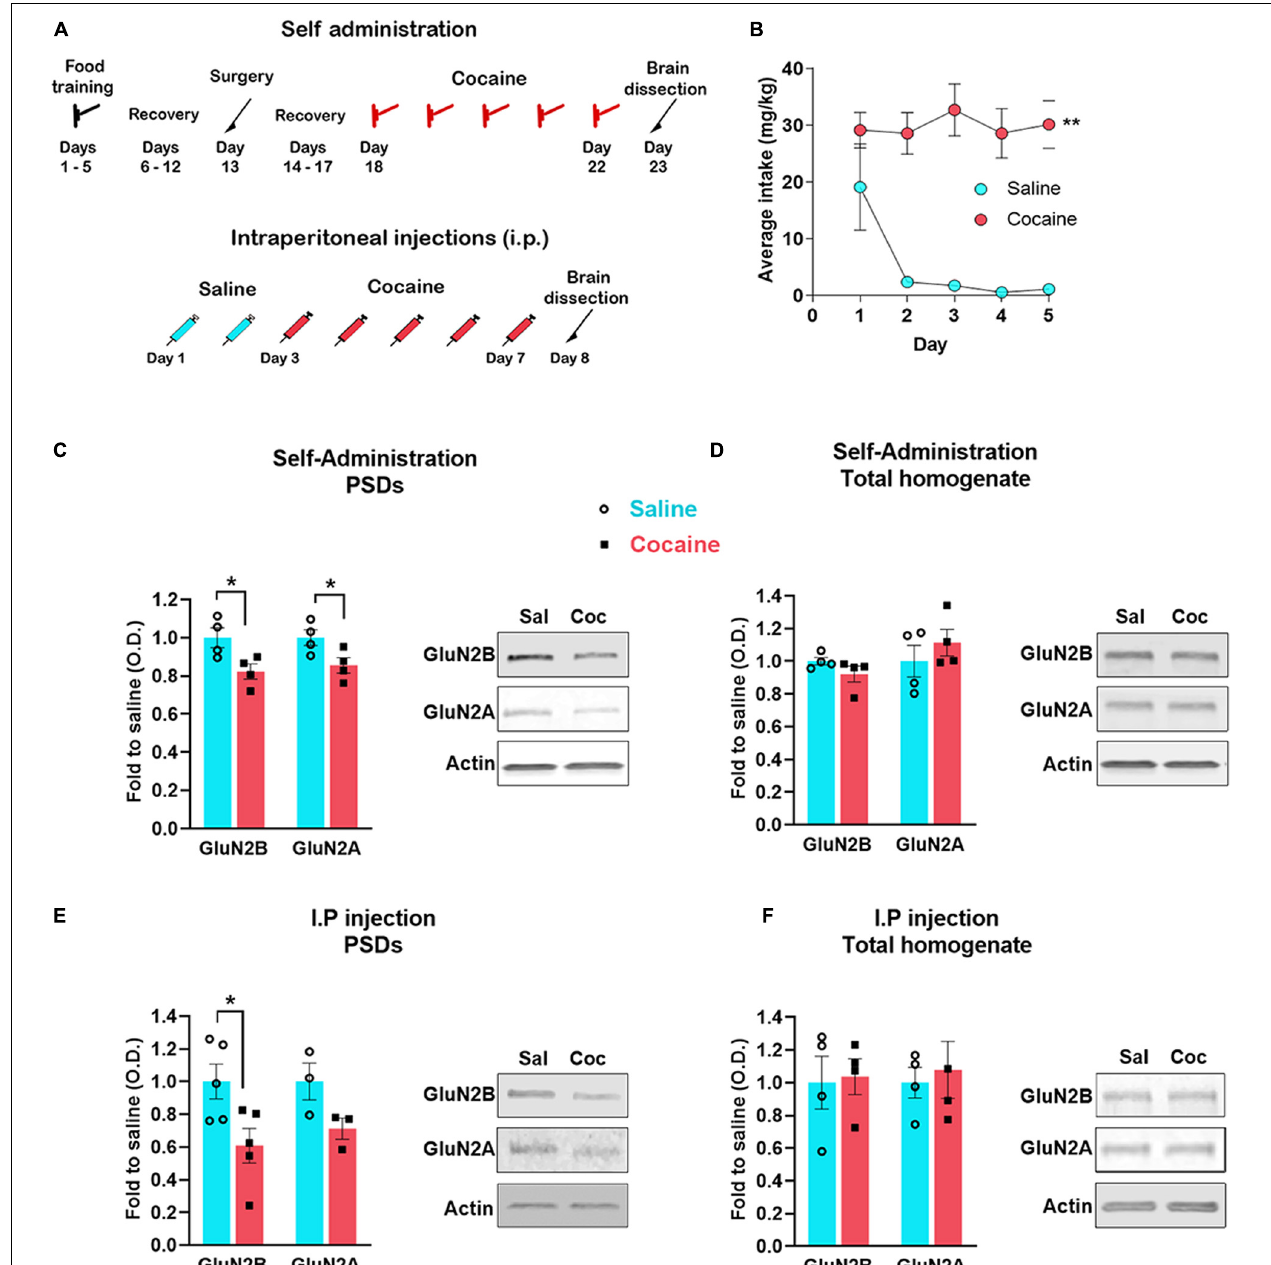
FIGURE 1 | Timeline of the experiments (A) . Cocaine self-administration (mean number of cocaine intake during the 2-h sessions) (B) . Accumbens shell was dissected 24 h after the last self-administration session ( n = 4 samples/group, 4 mice/sample, total of 16 animals/group) (C,D) or i.p daily injection of cocaine ( n = 5 samples/group, 4 mice/sample, total of 20 animals/group) (E,F) . PSD enriched fraction was analyzed by western blot to detect the indicated proteins (C,E) ; total protein extracted from the same samples was also analyzed (D,F) . Data are represented as mean ± SEM. * p < 0.05, ** p < 0.01.